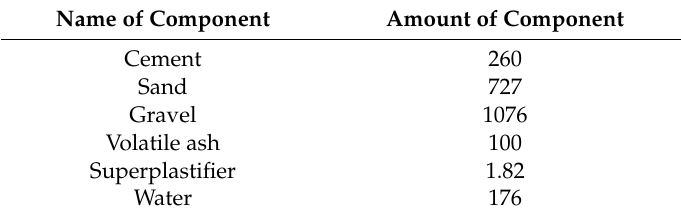
Table 1. Composition of control mixture in the event of weight–volume dosage in kg / m 3 .